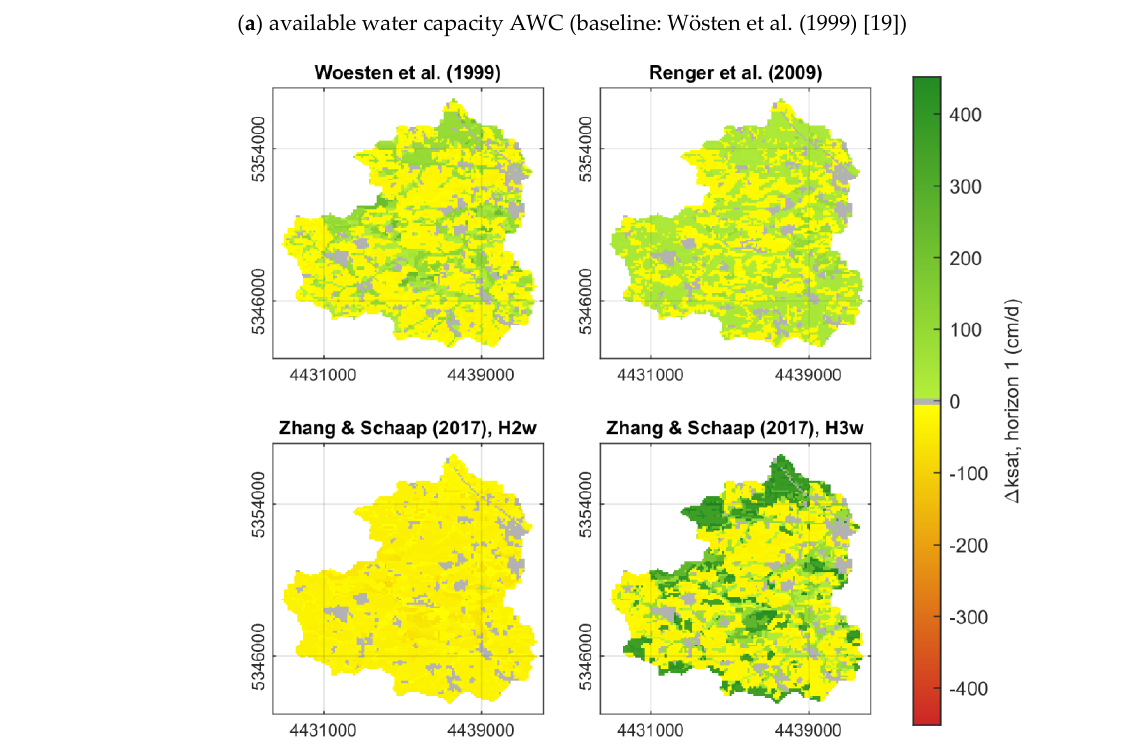
Figure 3. Spatial distribution of differences in soil hydraulic properties (∆AWC, ∆K sat ). AWC is calculated for the first meter of the soil profile and the K sat at the uppermost horizon of the soil profiles.